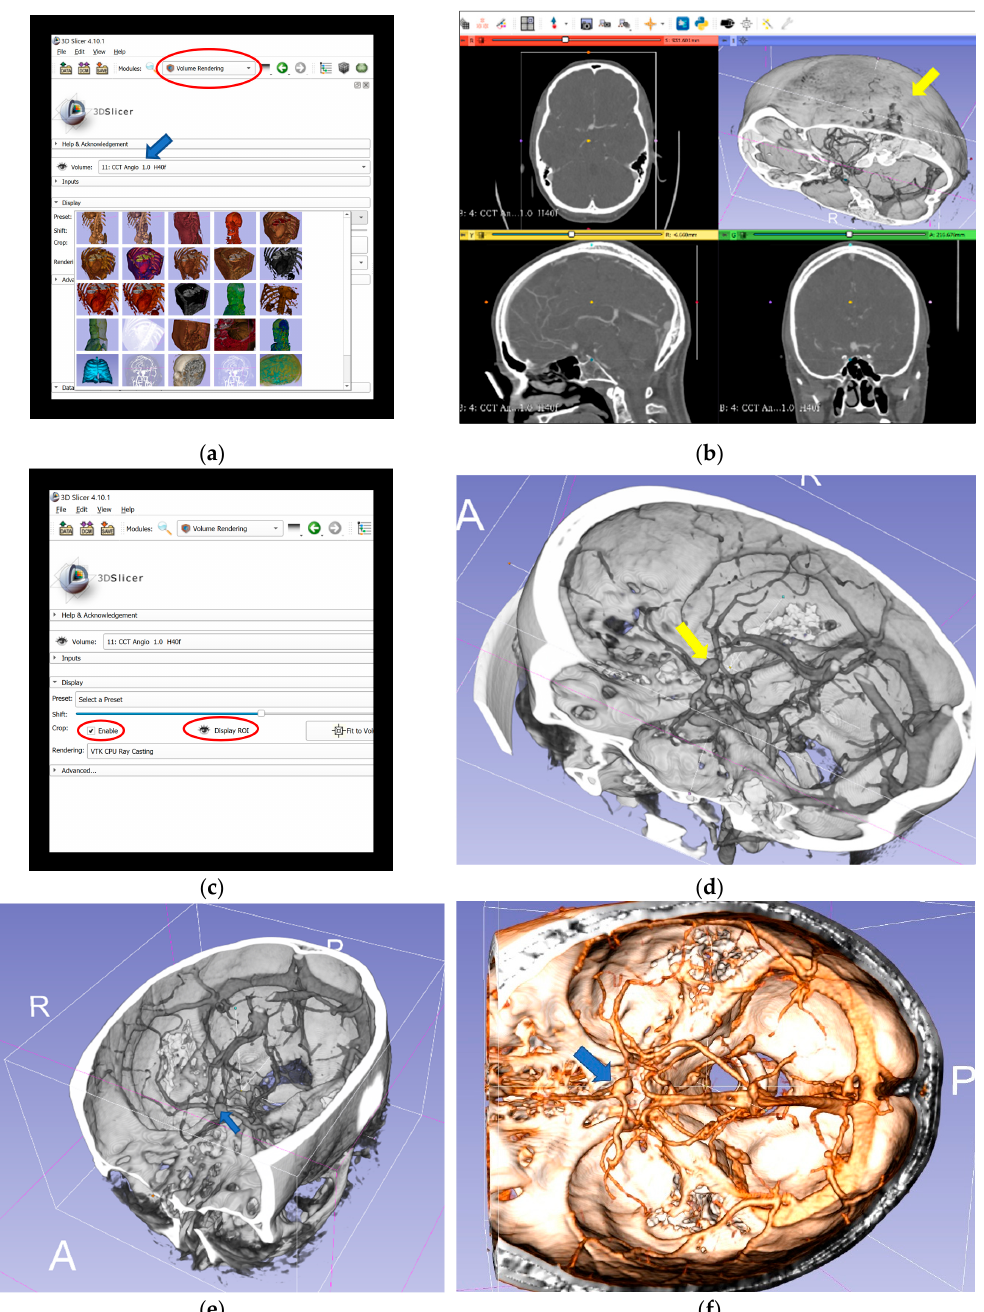
Figure 1. Reconstruction process of 3D ‐ VR images and completion of the final VR scene in 3D Slicer. ( a ) Import of the original CTA data in anonymized DICOM format into 3D Slicer software to create a patient ‐ specific database and selection of “CCT Angio ‐ Default” (blue arrow) in volume rendering window (red circled). ( b ) Performance of 3D ‐ VR reconstruction of skull and vessels (yellow arrow) in volume rendering window. ( c ) Activation of ROI function (red circled), which enables visualization of the aneurysm and relevant vascular anatomy through skull bones from different perspectives. ( d ) Lateral aspect of the aneurysm (yellow arrow) and relevant vascular anatomy, simplified using ROI function. ( e ) Oblique lateral aspect of the aneurysm (blue arrow). ( f ) Superior aspect of the aneurysm (blue arrow) with different color display. 3D, three ‐ dimensional; CCT, cranial computed tomography;